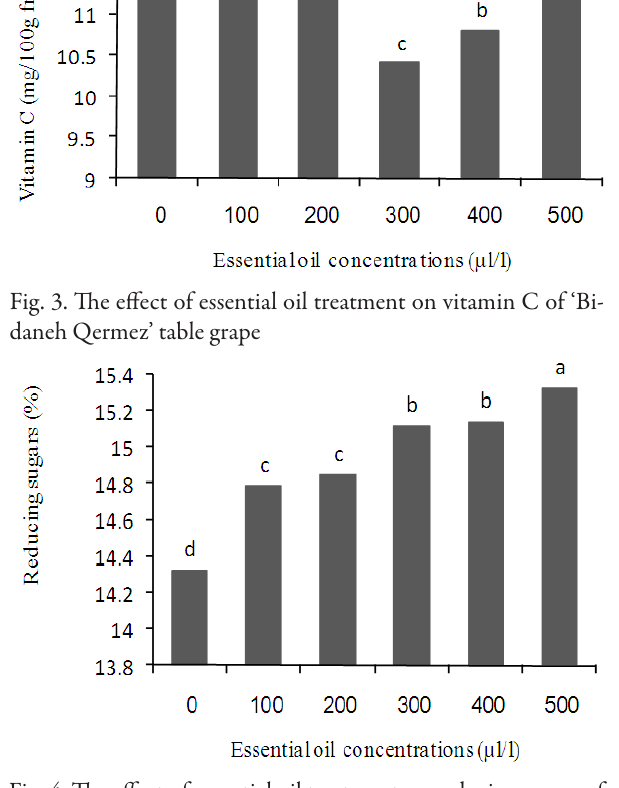
Fig. 4. The effect of essential oil treatment on reducing sugars of ‘Bidaneh Qermez’ table grape